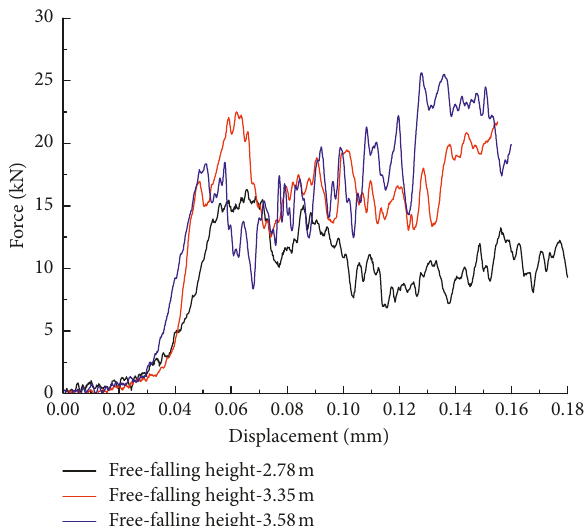
Figure 18: Dynamic tensile load-displacement curves of the tube- crushing dissipators.